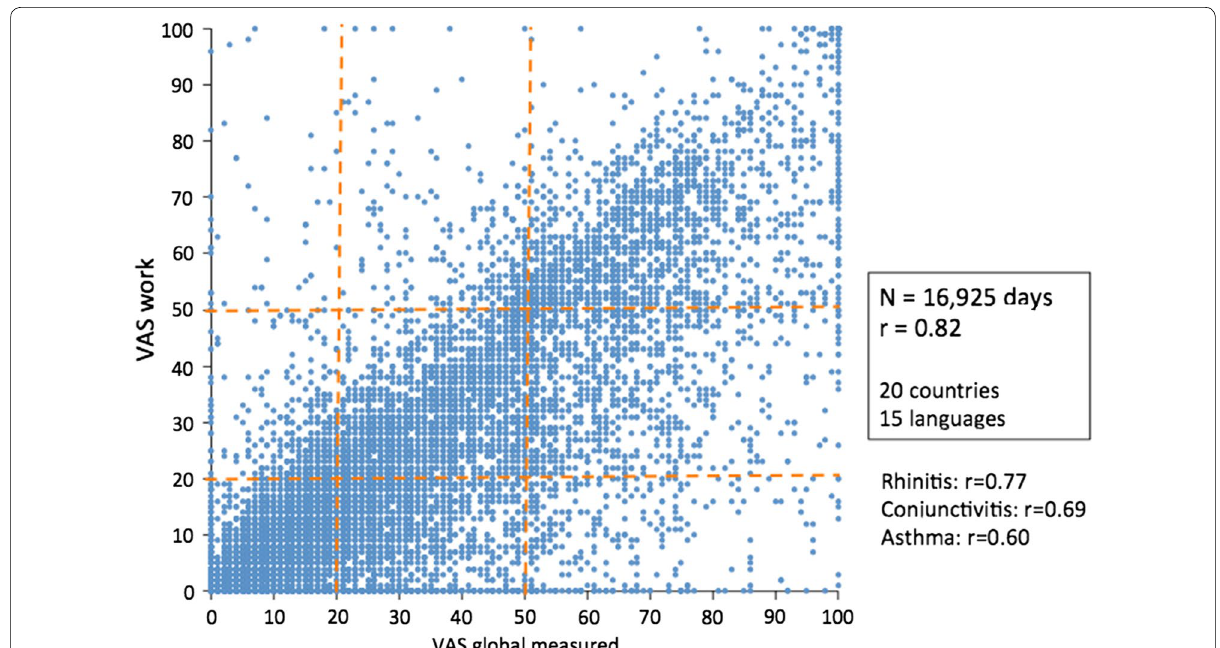
Fig. 7 Correlation between VAS work and VAS global measured, nose, eye and asthma (Bousquet unpublished)